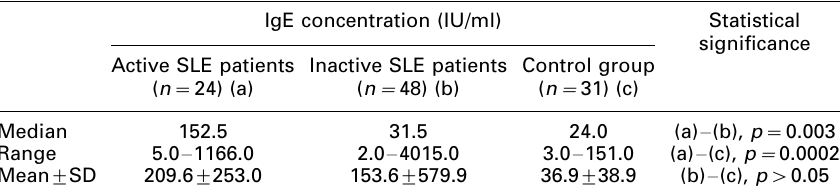
Table 3. Total IgE concentration in active and inactive SLE patients IgE concentration (IU/ml) Statistical